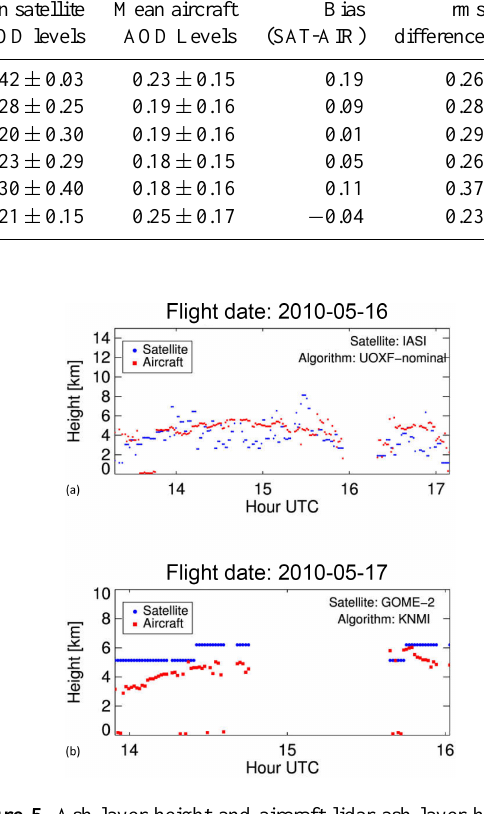
Figure 5. Ash layer height and aircraft lidar ash layer height (in km) at 355nm as a function of aircraft time: GOME-2A for 17 May 2010 (a) and IASI-UOXF for 16 May 2010 (b)